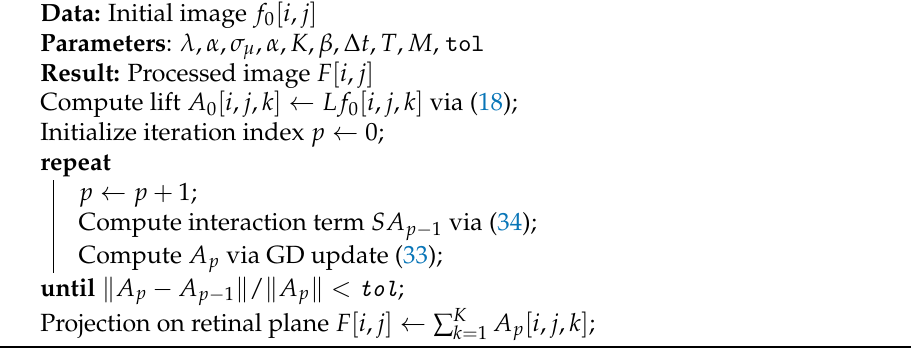
Algorithm 1: sR-WC and sr-LHE